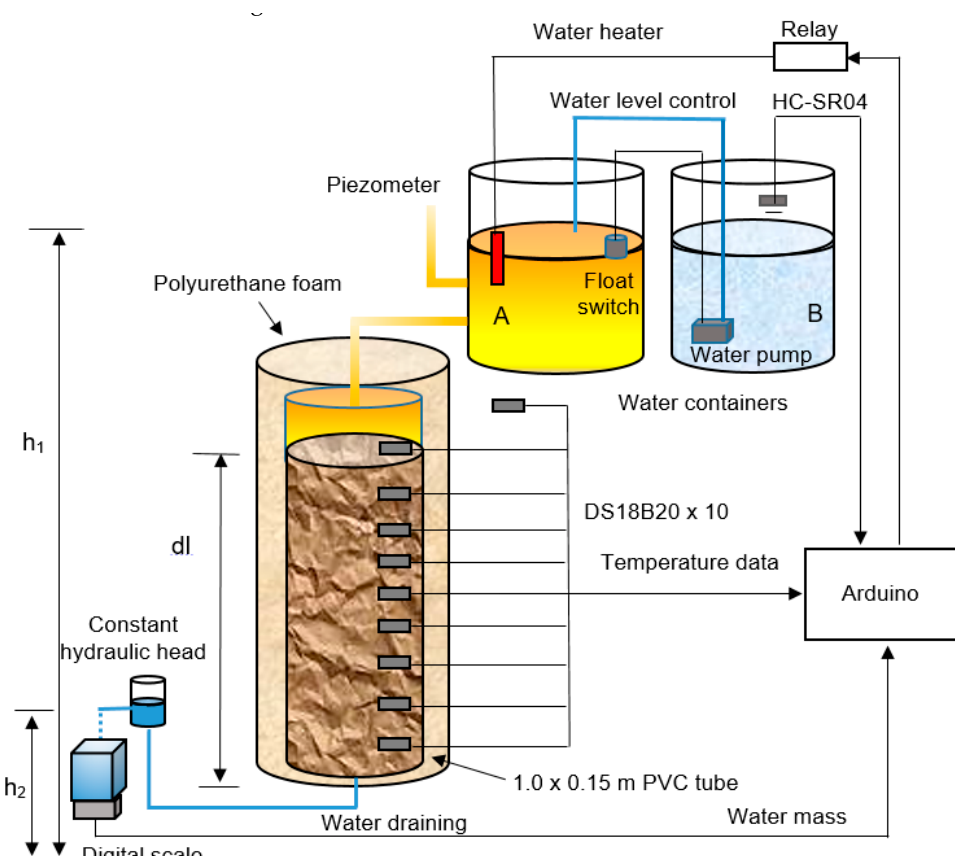
Figure 1. The Automated Laboratory Infiltrometer .